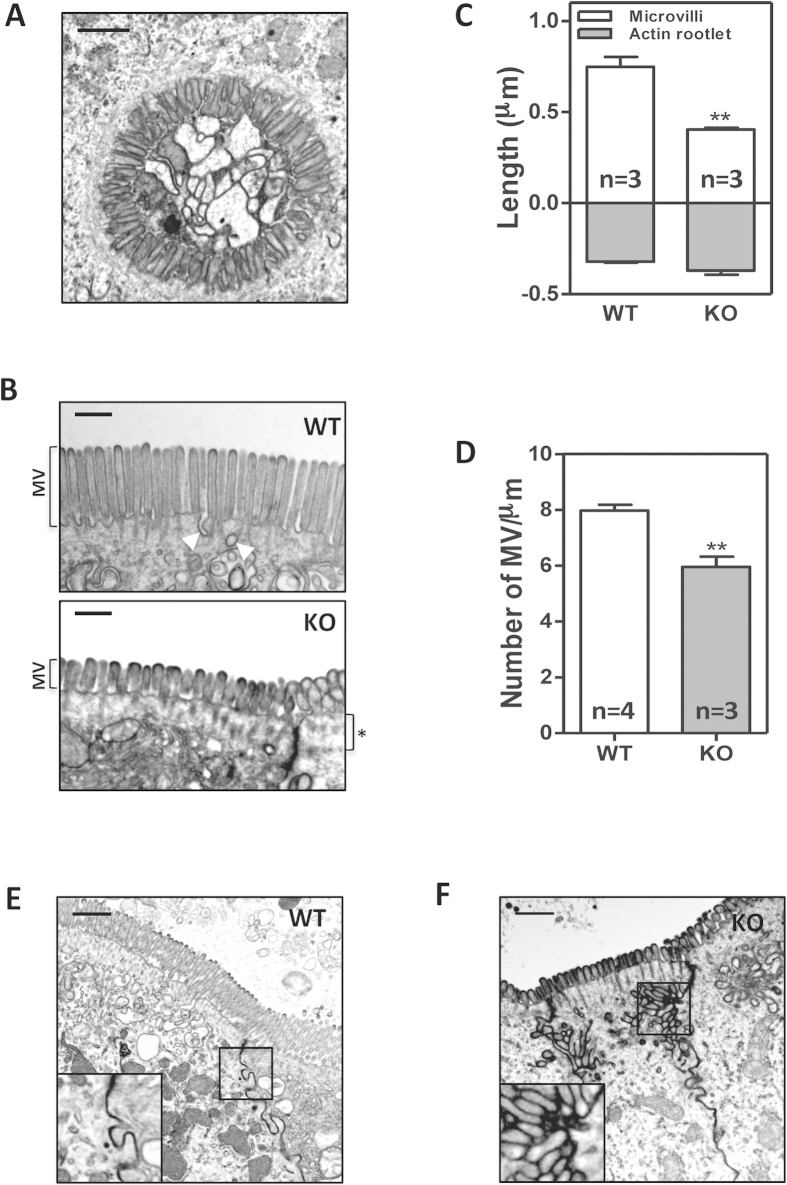
Ultrastructural defects in the intestinal epithelium of knockout Myo5b E20 embryos.(A) TEM micrograph showing microvillus inclusion bodies in Myo5b knockout E20 embryos (scale bar 0.5 μm). (B) Apical microvilli of enterocytes in Myo5b wild type and knockout E20 embryos (scale bar 0.5 μm). MV: microvilli; White arrowheads: subapical microvesicles; asterisk indicates a subapical region devoid of microvesicles. (C) Average (±SEM) length of microvilli projecting into the lumen and actin rootlets. (D) Number of microvilli observed per micrometer in transverse sections of the brush border. The normal junction between enterocytes in wild type Myo5b E20 embryos is shown in (E). Scale bar 1 μm. Microvilli-like structures could be observed in the lateral membrane of enterocytes in Myo5b knockout mice (F). Scale bar 1 μm. **p < 0.01 (Student’s T-test).